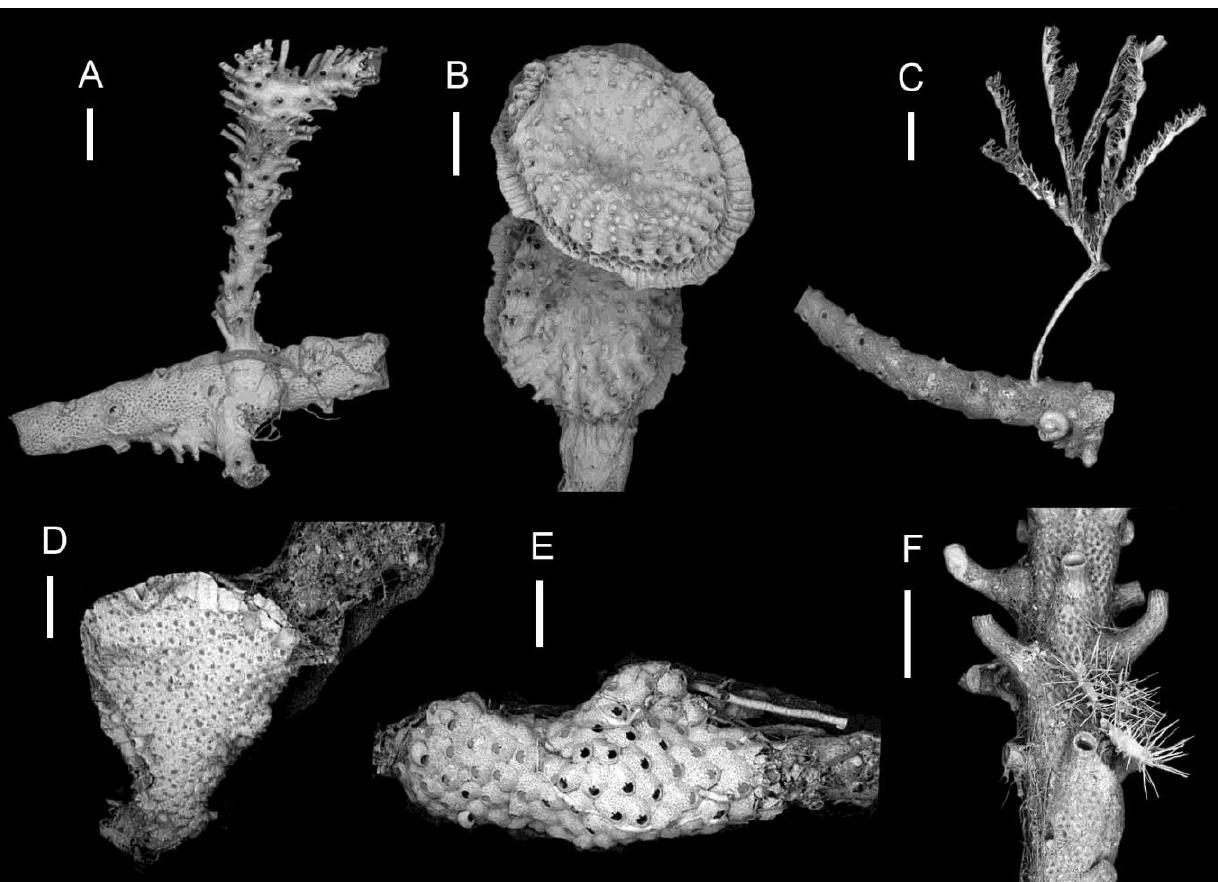
Figure 6. SEM images of bryozoans epibiont on Margaretta cereoides found in the studied E Build-up collected offshore Marzamemi (Ionian Sea). ( A ): Mecynoecia delicatula fertile colony. PMC. Rosso Collection I. H. B-59b. (Scale bar: 1 mm). ( B ) Plagioecia patina . The upper colony is peripherally budded from the lower one. PMC. Rosso Collection I. H. B-102a. (Scale bar: 1 mm). ( C ) Bugulina cf. fulva . PMC. Rosso Collection I.H. B-103a. (Scale bar: 1 mm). ( D ) Large colony of Schizomavella (Schizomavella) linearis . PMC. Rosso Collection I. H. B-104a. (Scale bar: 1 mm). ( E ) Arthropoma cecilii . PMC. Rosso Collection I. H. B-100a. (Scale bar: 1 mm). ( F ) Beania cylindrica . PMC. Rosso Collection I. H. B-101a. (Scale bar: 1 mm).